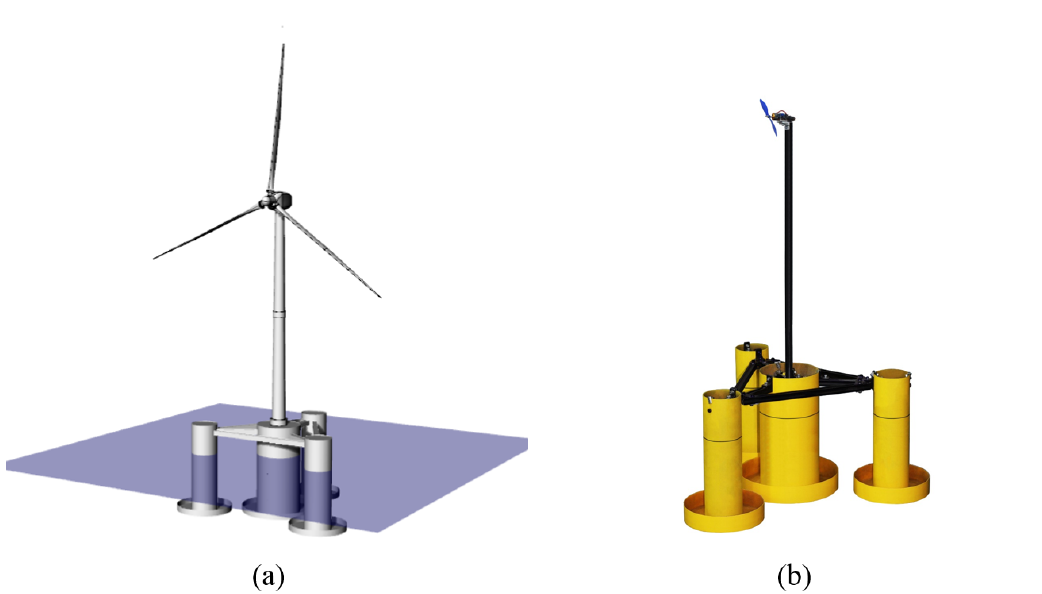
Figure 1. Details of the Jappaku Floating Offshore Wind Turbine (FOWT): ( a ) concept for the full scale and ( b ) model scale